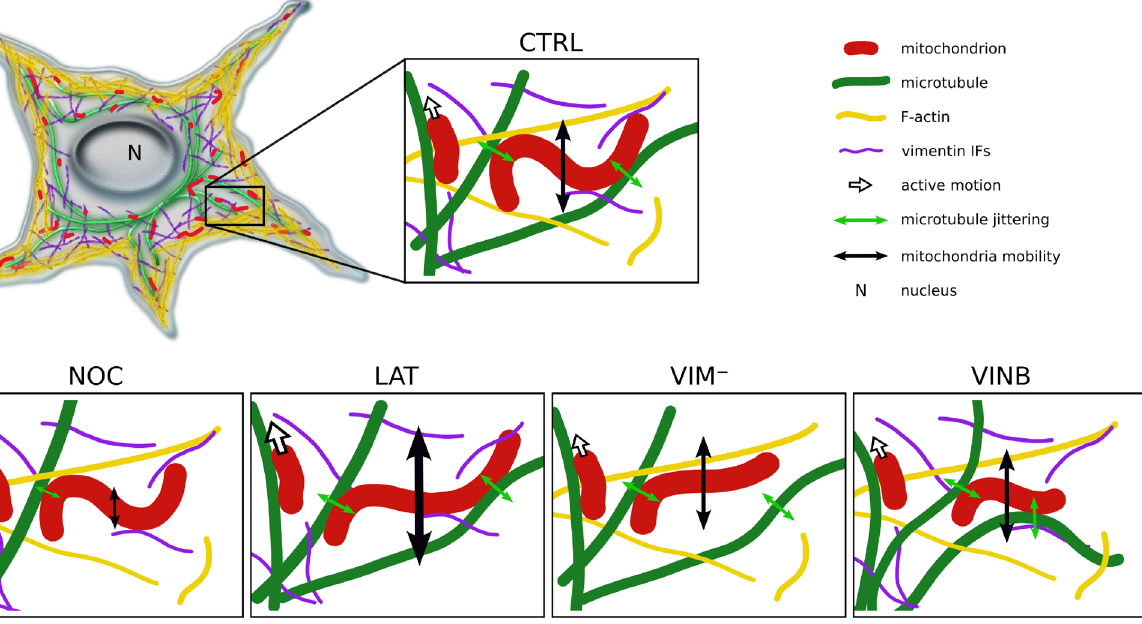
Figure 4. Summary of the modulation of mitochondrial shape fluctuations and mobility by the cytoskeleton. Mitochondria are in close association with microtubules, being transported through them and modifying their shape as a consequence of the jittering transmitted by these filaments (green double arrows) and the interactions with F-actin and vimentin IFs, both of which would contribute to maintain mitochondria confined to microtubule network. Upon partial depolymerization of microtubules (NOC), both the mobility of the organelles (schematized with the black double arrows) and the mechanical force imposed on them decrease. − Given the disruption of F-actin (LAT) and vimentin IFs (VIM ) networks, a predominance of elongated mitochondria is observed, suggesting that these filaments also modulate the organelles’ shape. F-actin depolymerization also results in increased mitochondrial mobility, suggesting that these filaments impose greater spatial confinement that restricts their motion. Perturbation of microtubule dynamics (VINB) decreases mitochondrial curvature and length compared to the control condition (All images created by A.B. Fernández